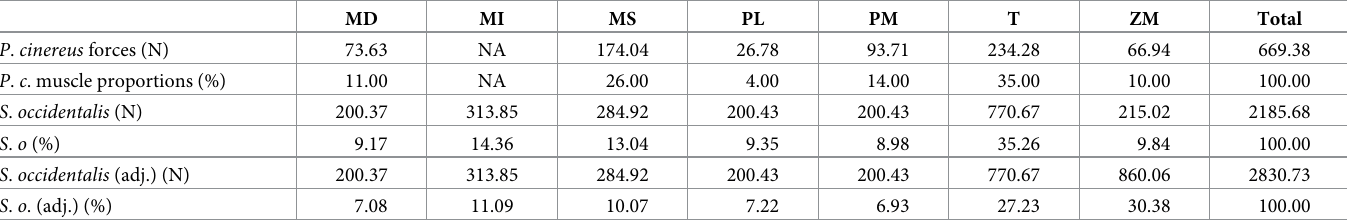
Table 1. Muscle forces (N) and proportions of total muscle force (%) applied to each finite element model: The koala ( Phascolarctos cinereus ), Simosthenurus occi- dentalis with tree-kangaroo muscle proportions, and the second S . occidentalis model with and adjusted (adj.) ZM